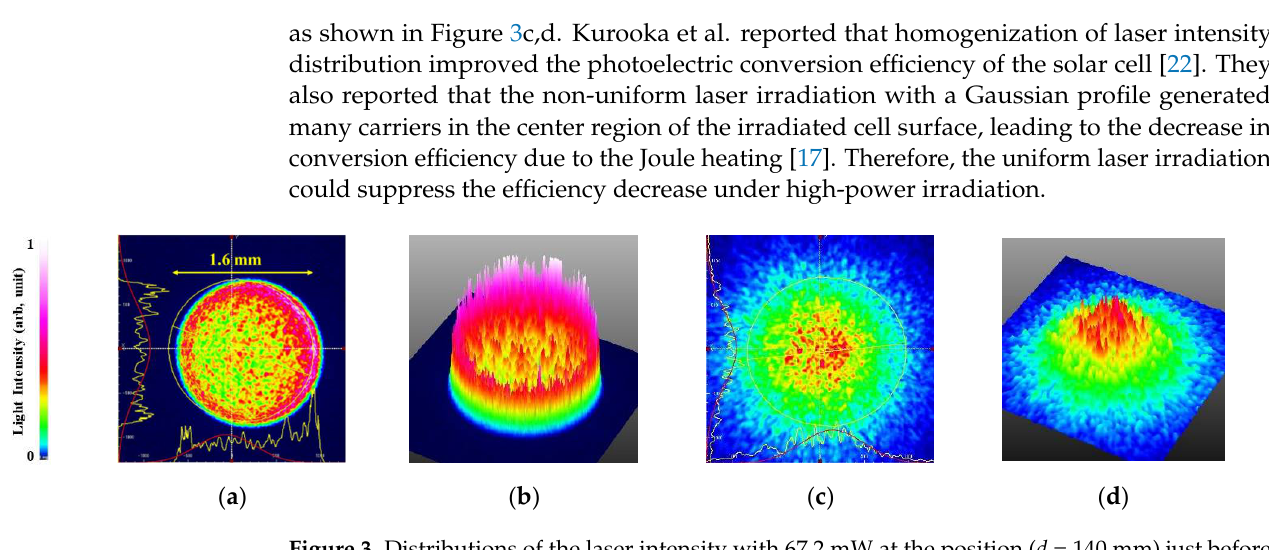
Figure 3. Distributions of the laser intensity with 67.2 mW at the position ( d = 140 mm) just before the focal position in ( a , b ) and at the position ( d = 160 mm) behind the focal position in ( c , d ).